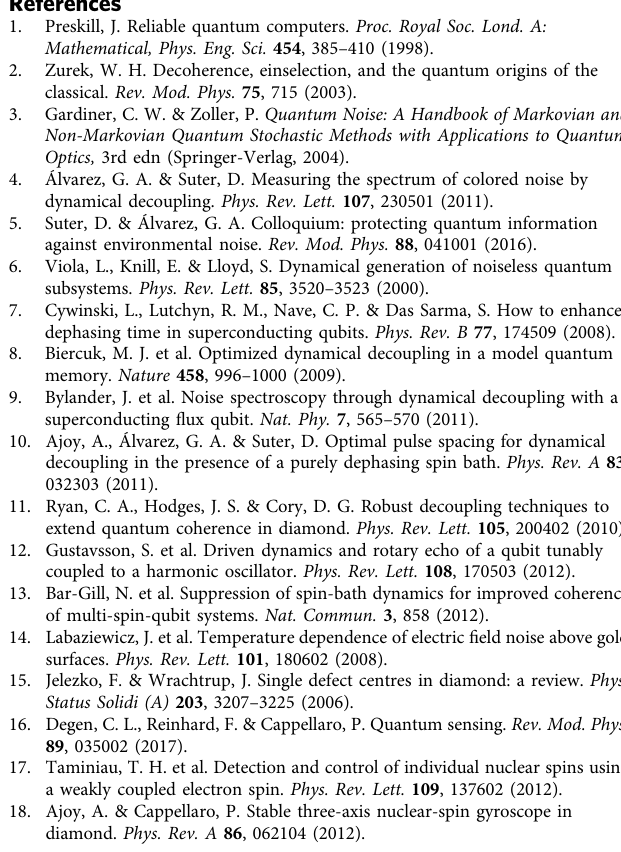
Fig. 6 Dynamic optical engineering of electron spin density. Panel a denotes 13 C relaxation rate on a logarithmic scale for Sample 1 employed in Fig. 3 with relaxation dark (red points) and under low power (80 mWmm − 2 ) blue (465 nm) irradiation (blue points). Shaded regions represent error bounds (see Supplementary Note 3C). b Schematic time sequence of the experiment. c Exemplary decay curves obtained at 20 mT. d Relaxation rates on linear fi eld scale. We observe that the blue irradiation leads to a decrease in 13 C nuclear lifetimes, which we hypothesize arises from fl uctuations introduced in the electronic spin bath upon recapture after P1 center ionization. This illustrates that the electronic spin spectral density can be optically manipulated, and potentially ultimately also narrowed under suf fi ciently high-power ionization